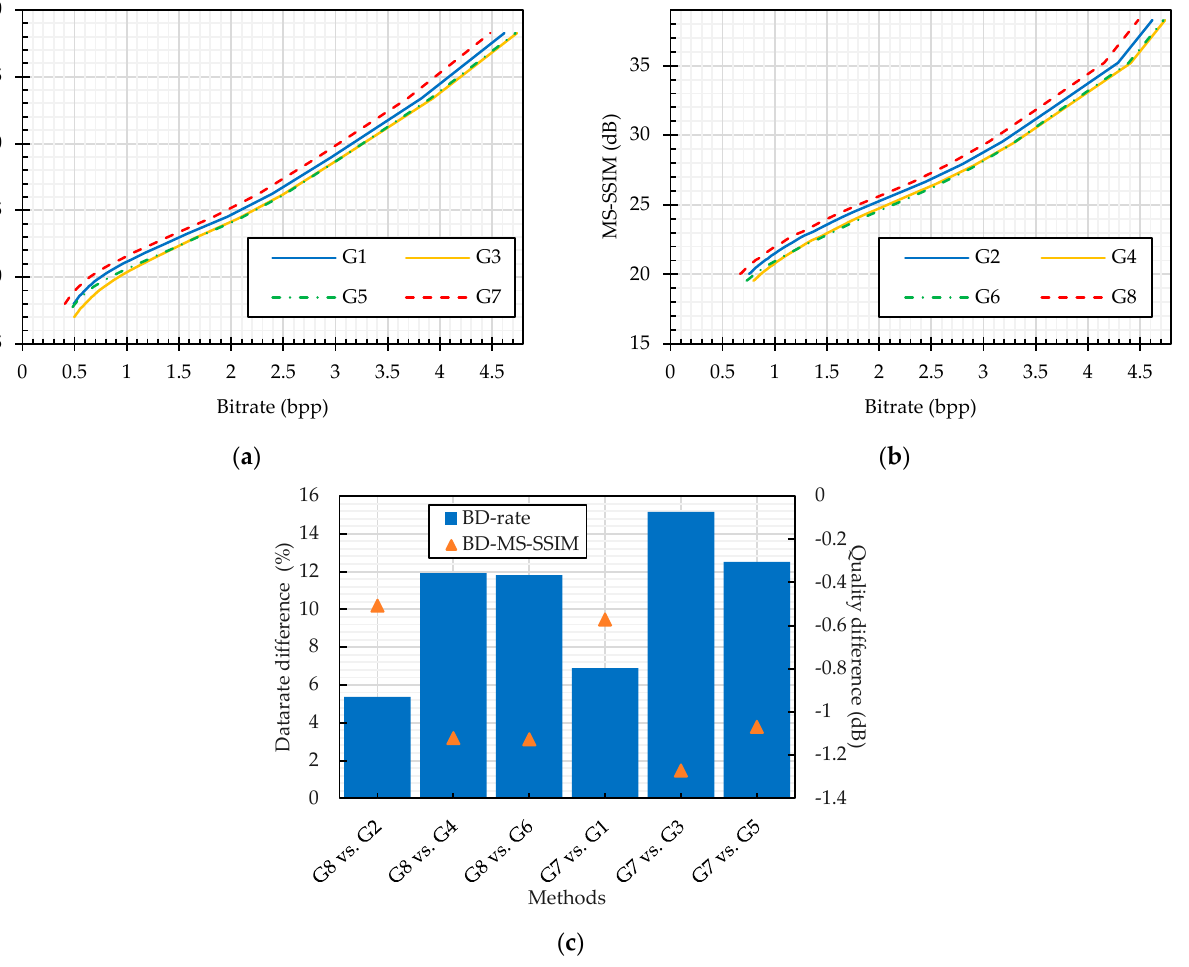
Figure 19. The JPEG compression analysis of plain and PE images. The compression was carried out using the chrominance table ( a ) and the luminance table ( b ). ( c ) is the BD–measures plot.